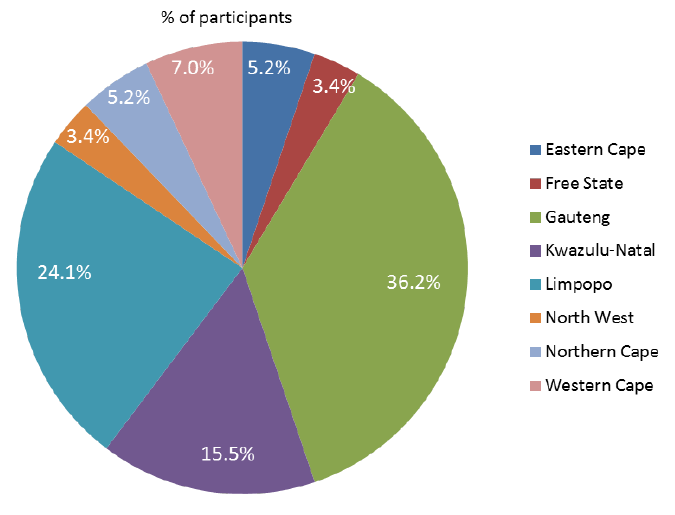
Figure 1. Regional profile of